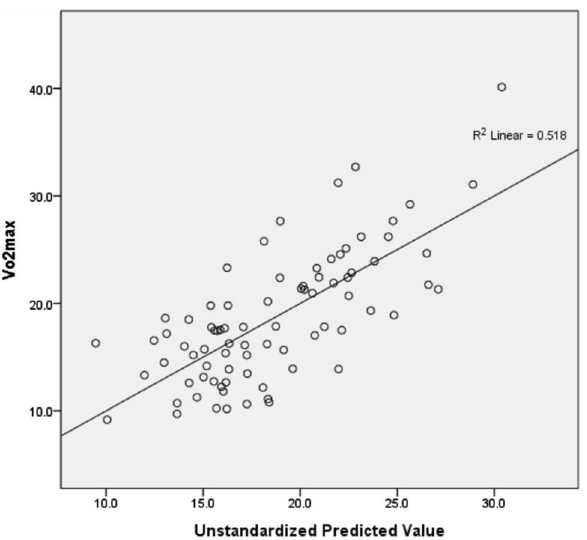
Figure 1. Scatter plots for multiple regression